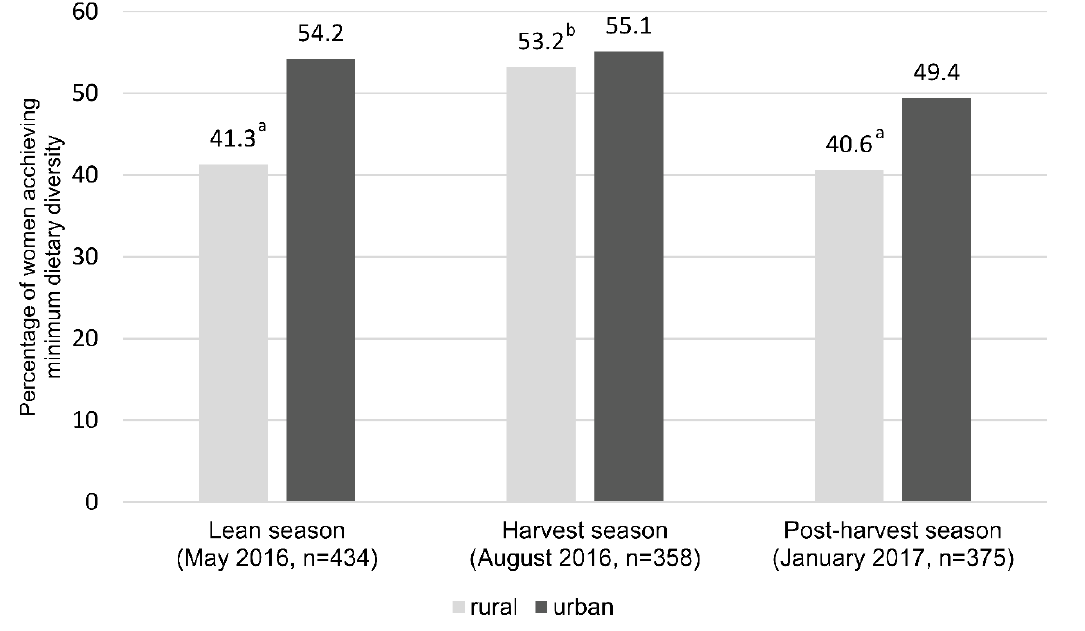
Figure 3. Percentage of women achieving minimum dietary diversity in rural and urban settings at the different agricultural seasons. Wilcoxon Test, a/b = statistically significant different at p < 0.001 level.